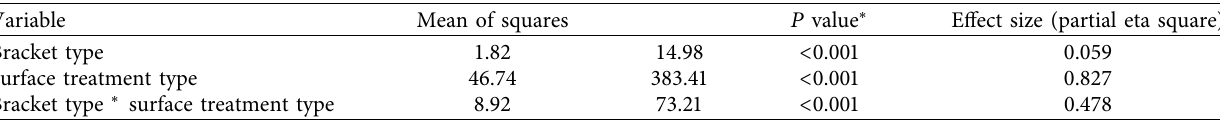
Table 2: Effect of orthodontic bracket type and surface treatments on SBS of zirconia using two-way ANOVA. Variable Mean of squares P value